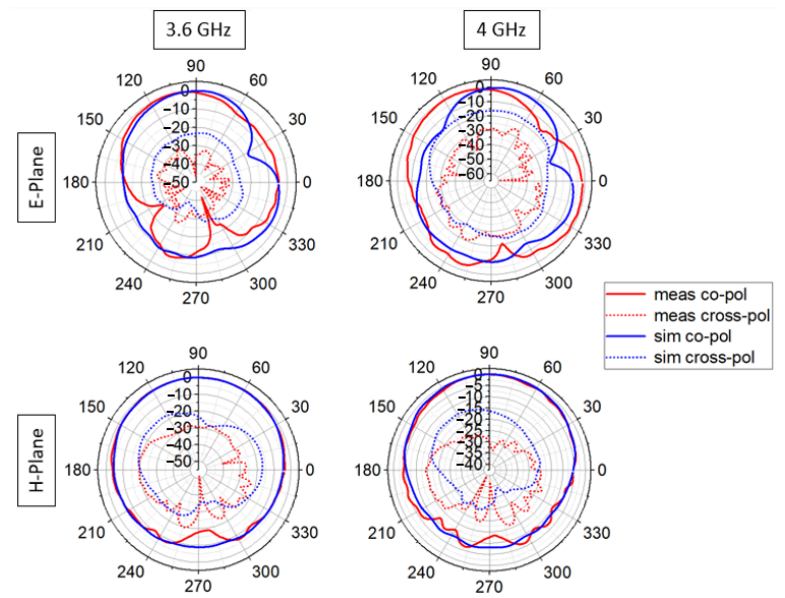
Figure 20. Simulated and measured radiation patterns (gain in dB) of the fabricated prototype of the proposed antenna 2.